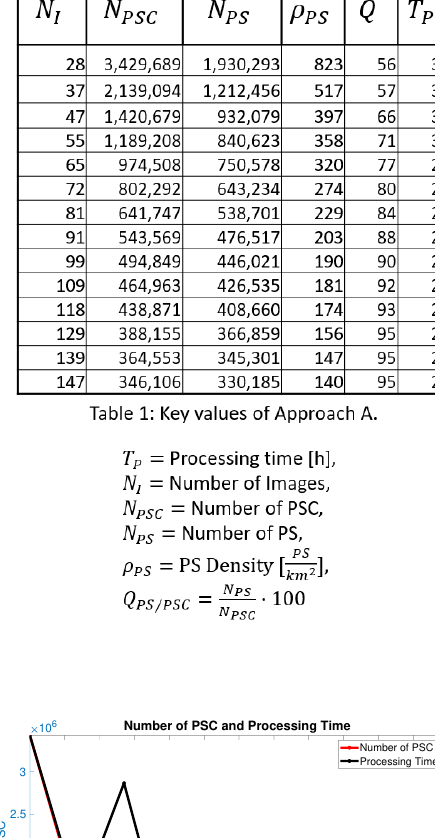
The second question relates to the percentage of initially se- lected PSC, which are actually identified as PS. The graphs of N PSC (blue) and N PS (red) follow a similar trend as shown in Figure 4. Though, as expected there is an offset between them. The number of selected PSC is usually higher than the num- ber of identified PS. This offset, however, decreases with an increasing number of images. This is also reflected in the black graph of Figure 4, which illustrates the percentage Q of PSC ac- tually identified as PS. Q increases with increasing number of images, as is shown in Figure 4. For the base dataset, only 56 % of the PSC turned out to actually be PS and after the last update, the percentage has increased to 95 %. Therefore, the conclusion can be made that the longer the time series is, the higher is the probability that a PSC is identified as a PS. Though a draw- back of longer time series is that short term deformations are not noticeable anymore. In addition to the analysis of the nu- meric values, a visual comparison of the results was